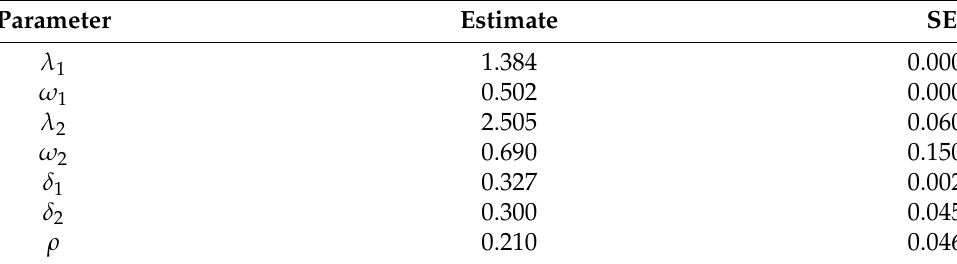
Table 8. Parameter estimates for the bivariate zero-inflated Poisson